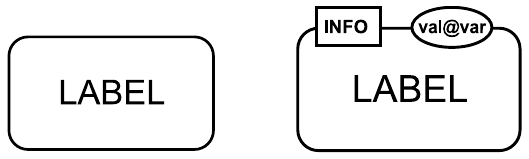
Figure 2.10: The Process Description glyph for macromolecule , shown plain and unadorned on the left, and with with an additional state variable and a unit of information on the right.